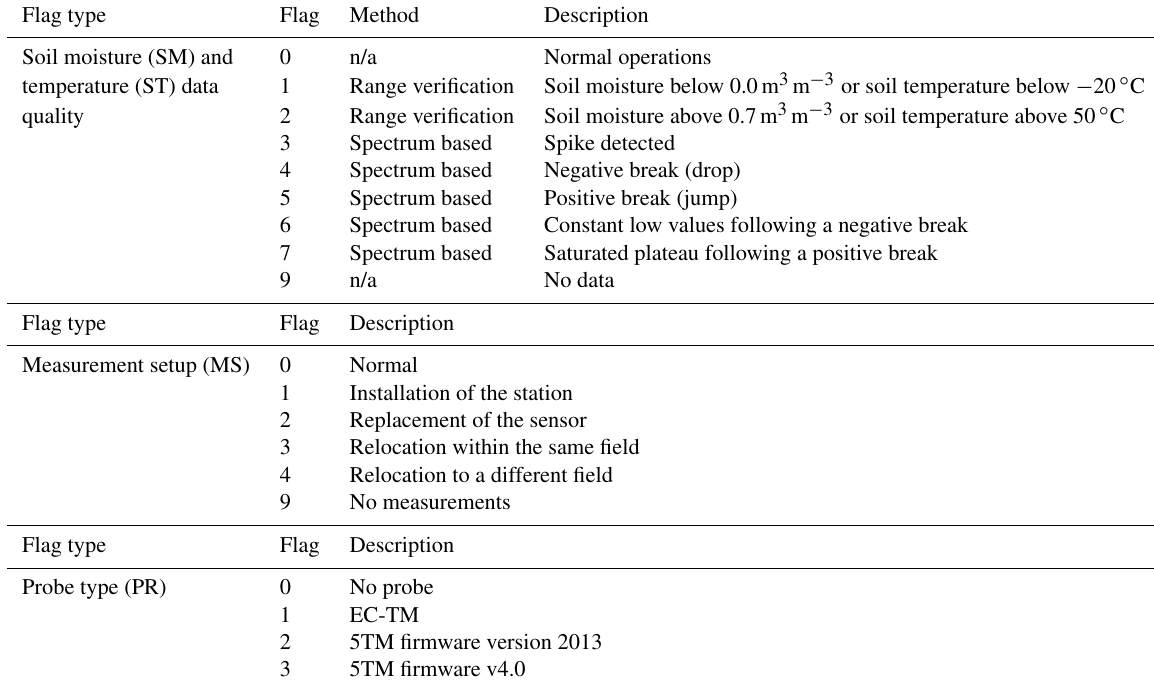
Table 6. Soil moisture and temperature data quality, measurements, setup and probe-type flags included in the DQ files created based on the calibrated data files. n/a stands for “not